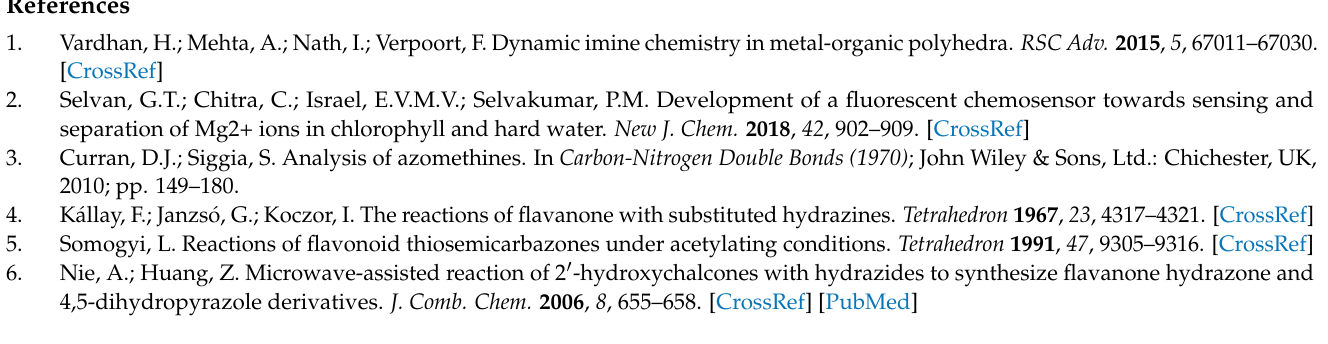
FTSC (1). Figure S9. 1 H NMR spectrum of compound FTCH (2). Figure S10. 1 H NMR spectrum